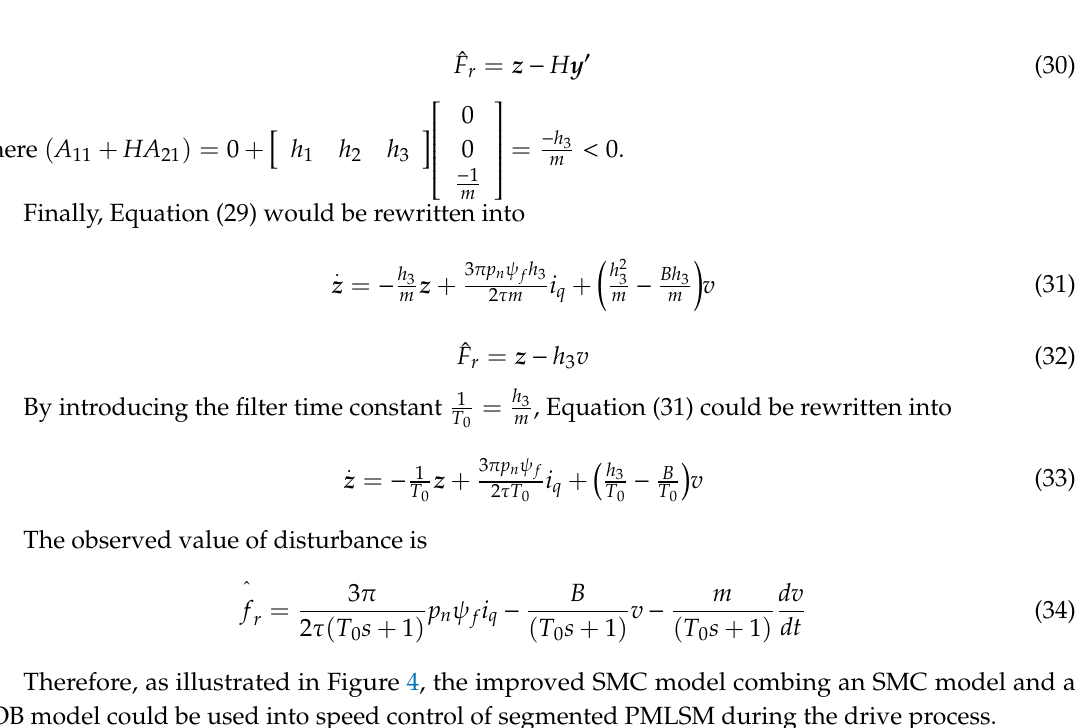
Figure 5. Control model of segmented PMLSM during switch process. In the meanwhile, the equivalent inductances of stator winding when the PM actuator slides in and out stator winding could be expressed into {